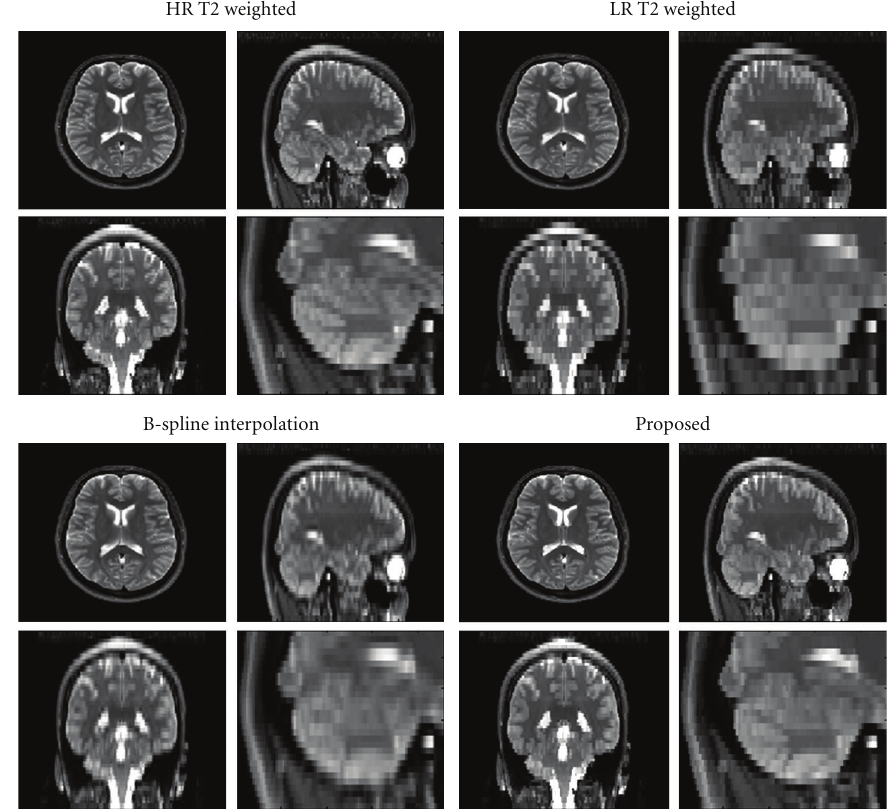
Figure 6: Comparison on real clinical data. Top-Left: HR T2-w volume. Top-Right: downsampled version of the HR T2-w volume. Bottom- Left: B-spline reconstruction. Bottom-right: reconstruction using the proposed method. Note that the proposed methodology yields a significantly less blurred reconstruction than other methods compared. A close-up of the cerebellum area clearly shows the improved reconstruction.